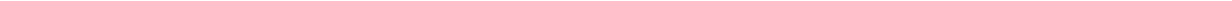
Fig. 5 hnRNP A1 recognizes the terminal loop of pri-mir-18a. a Structural model of the 71-mer pri-mir-18a/UP1 complex. The region corresponding to the 12-mer RNA in the terminal loop of the pri-mir-18a is shown in dark magenta. b Footprint analysis of the pri-mir-18a/UP1 complex. Cleavage patterns were obtained for 5 ′ 32 P-labeled pri-mir-18a transcript (100 × 10 3 c.p.m.) incubated in the presence of recombinant UP1 protein ( + 200 ng, 500 nM), treated with Ribonuclease T1 at 1.5 U/ μ L. F and T identify nucleotide residues subjected to partial digest with formamide (every nucleotide) or ribonuclease T1 (G- speci fi c cleavage), respectively. The cleavages intensities generated by Ribonuclease T1 are indicated on the pri-mir-18a secondary structure. The region of the major UP1 footprints is indicated by a blue oval shape. Residues that show enhanced reactivity upon UP1 binding are indicated by green arrows. c A schematic model of the effects of hnRNP A1 on pri-mir-18a. Binding of UP1 to the terminal loop, where each RRM domain recognizes a UAG motif, leads to melting of the terminal loop that then spreads down leading to destabilization and enhanced dynamics in the RNA stem, thereby facilitating Drosha cleavage by unknown mechanisms. d Averaged SHAPE and NMR data were used to calculate the secondary structure of pri-mir-18a free and when bound to UP1. SHAPE data were implemented in RNAstructure 31 as a soft constraint, while base pairs identi fi ed by NMR were used as hard constraints. The structures shown correspond to the lowest free energy models. Color coding corresponds to SHAPE reactivity as indicated with red/orange/yellow corresponding to high/semi/low